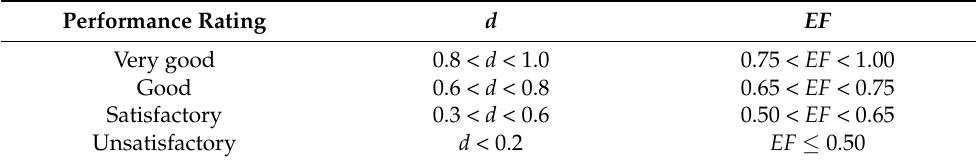
Table 5. General performance rating for model evaluation statistics